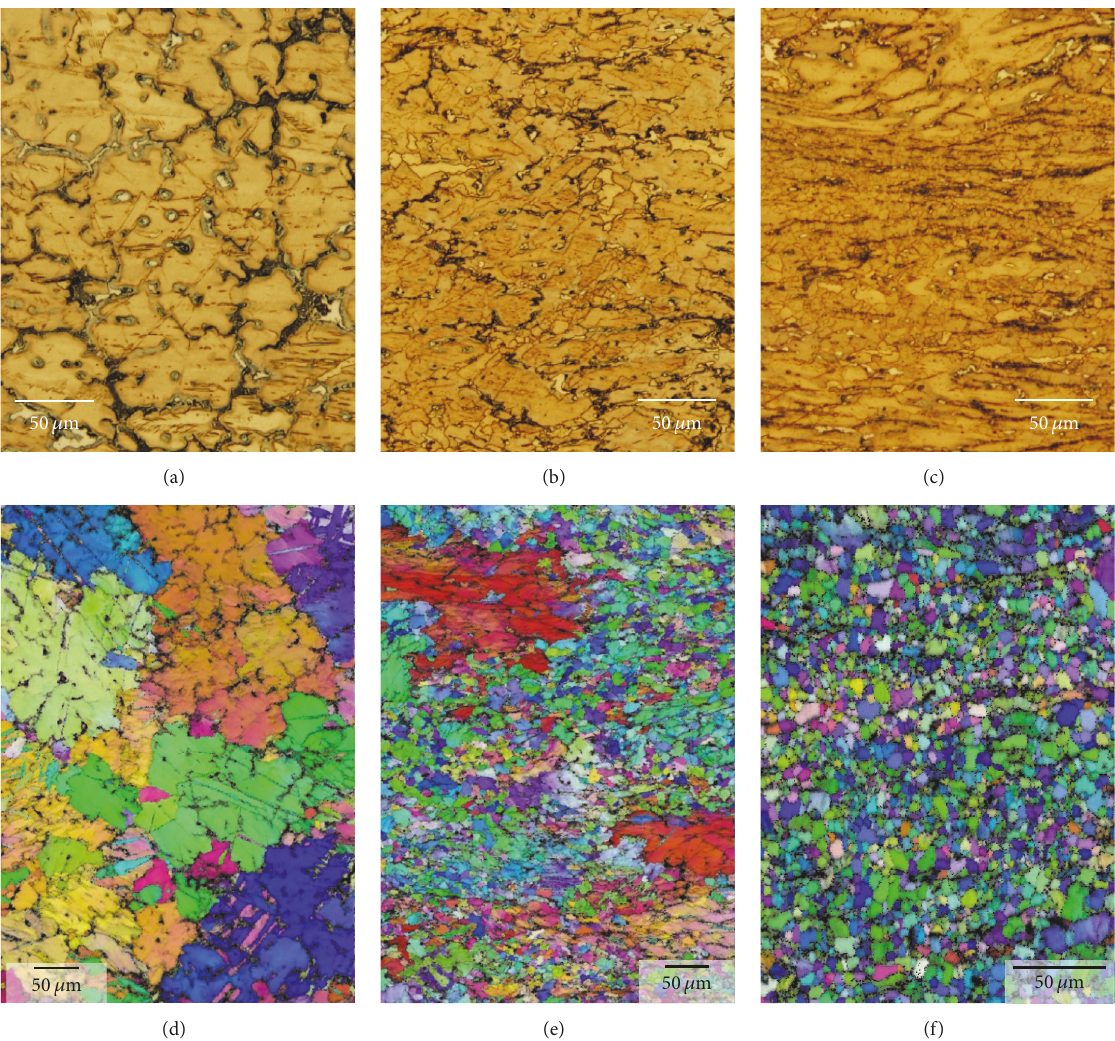
Figure 4: Optical micrographs and inverse pole figure maps of the AZX811 hot-rolled alloy. Total reduction ratios are as follows: (a), (d) 8.3%; (b), (e) 42%; and (c), (f) 75%.